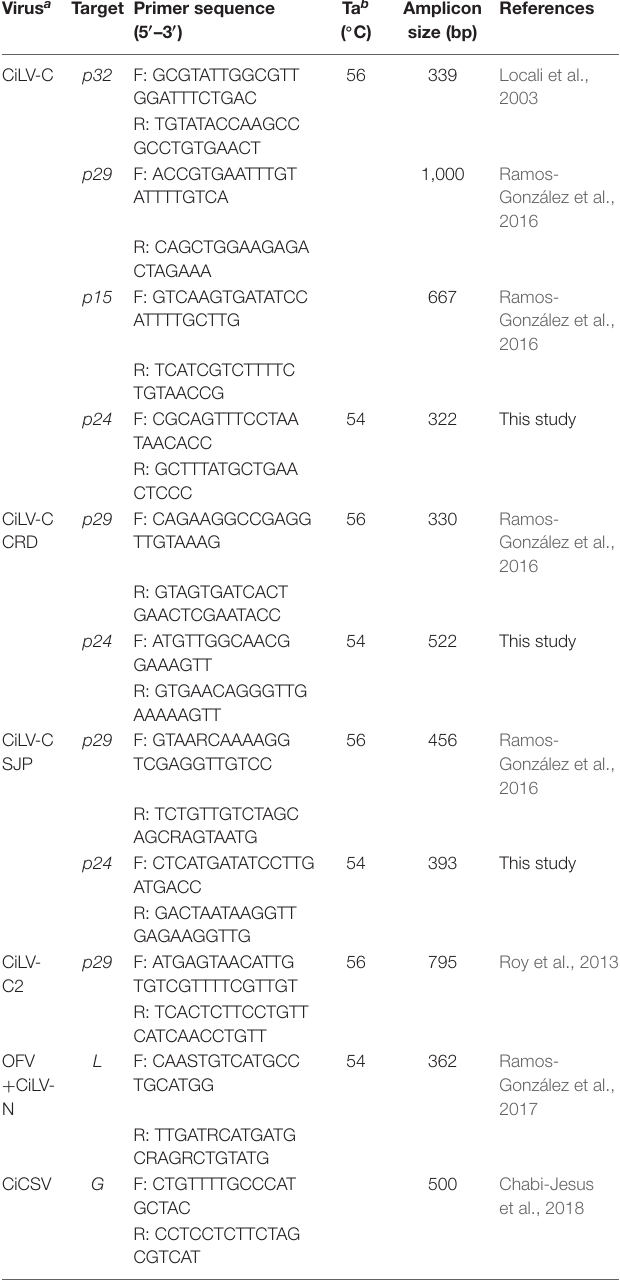
TABLE 2 | Primer list used for the detection of viruses associated with citrus leprosis disease by reverse transcription-polymerase chain reaction. Virus a Target Primer sequence (5 (cid:48) –3 (cid:48) )